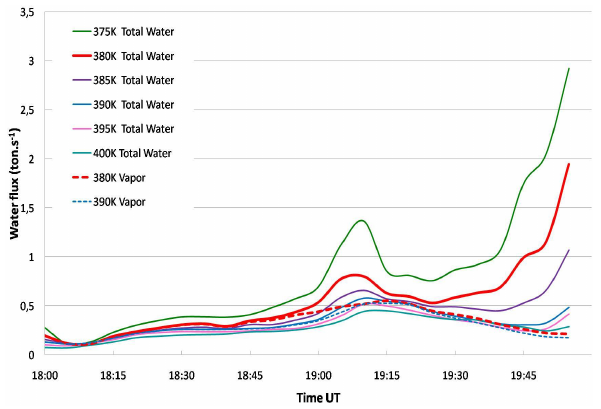
Fig. 17. Same as Fig. 14 but for the A¨ır case, computed between Fig. 17 18:00UT and 19:50UT on 5 August